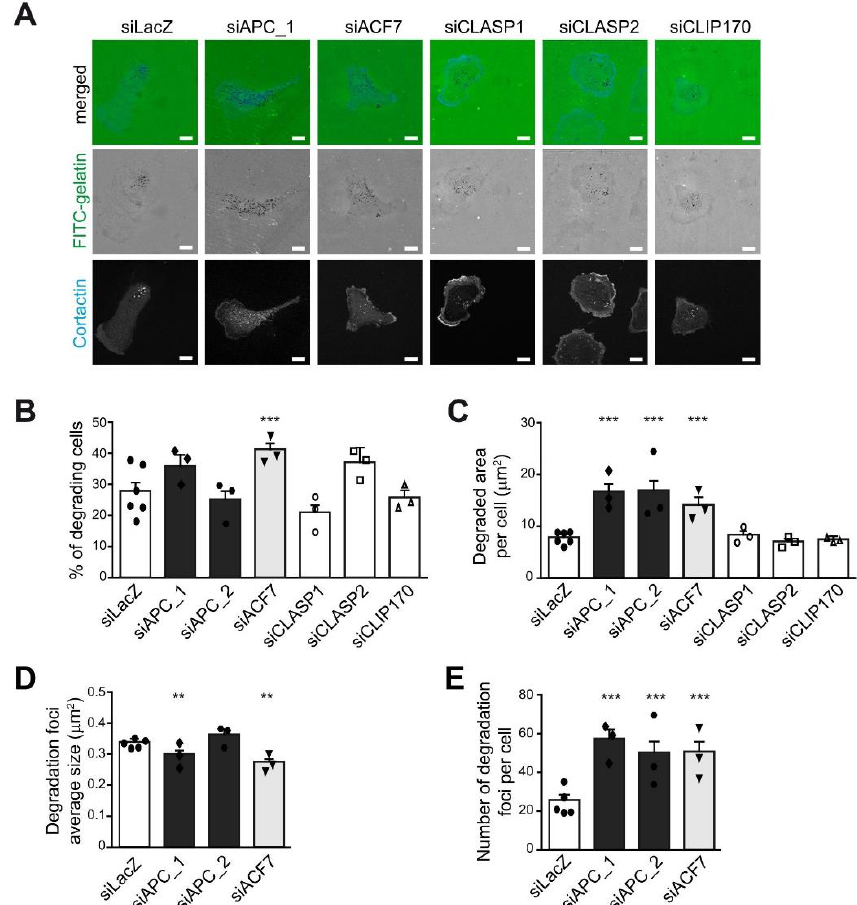
Figure 3. APC and ACF7, similarly to EB1, restricted ECM proteolysis by restraining invadopodia formation. MDA-MB-231 cells were transfected with a control siRNA control (siLacZ) or siRNA against APC (siAPC_1, siAPC_2), ACF7 (siACF7), CLASP1 (siCLASP1), CLASP2 (siCLASP2), and CLIP170 (siCLIP170) and seeded on fluorescently-labeled gelatin (FITC-gelatin) for 4 h. Cells were fixed and stained with an anti-Cortactin antibody to identify cell boundaries and invadopodia. Matrix degradation was identified thanks to the appearance of dark spots in FITC-gelatin. ( A ) Representative images are shown. Scale bars represent 10 μm. The ability of MDA-MB-231 cells described in ( A ) to degrade fluorescently-labeled gelatin was analyzed. The percentage of degrading cells ( B ), the degraded area per cell ( C ), the average size of degradation foci ( D ), and the number of degradation foci ( E ) are represented as the mean ± SEM of three independent experiments. The mean of each individual experiment is reported. Statistical analysis was performed as described in Figure 1. *** p ≤ 0.001, ** p ≤ 0.01.